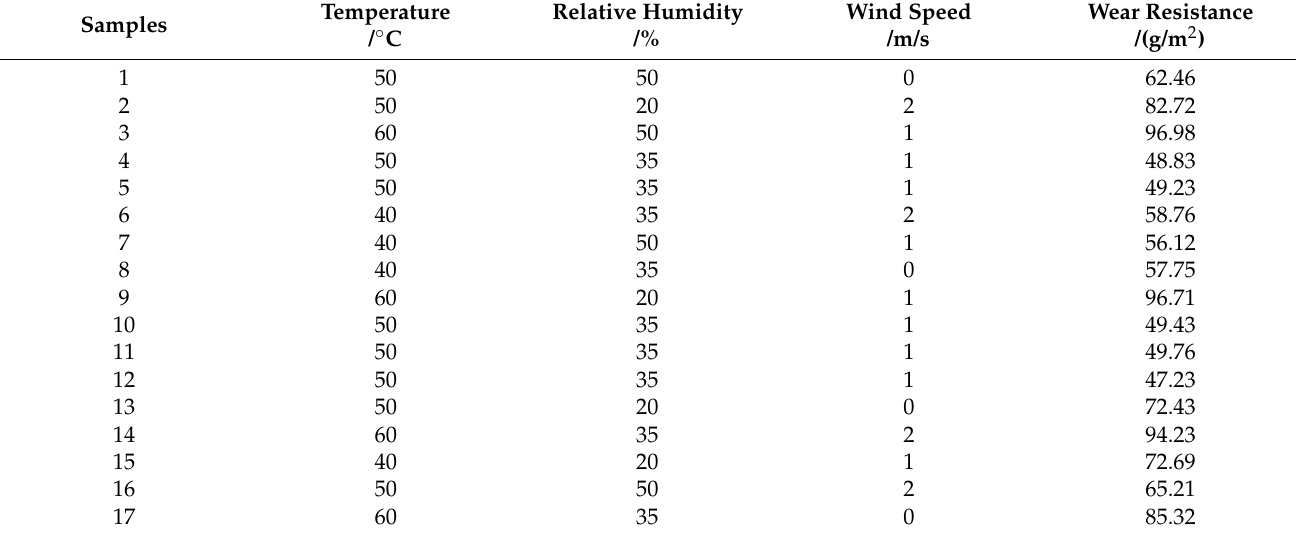
Table 5. Results of the wear resistance.